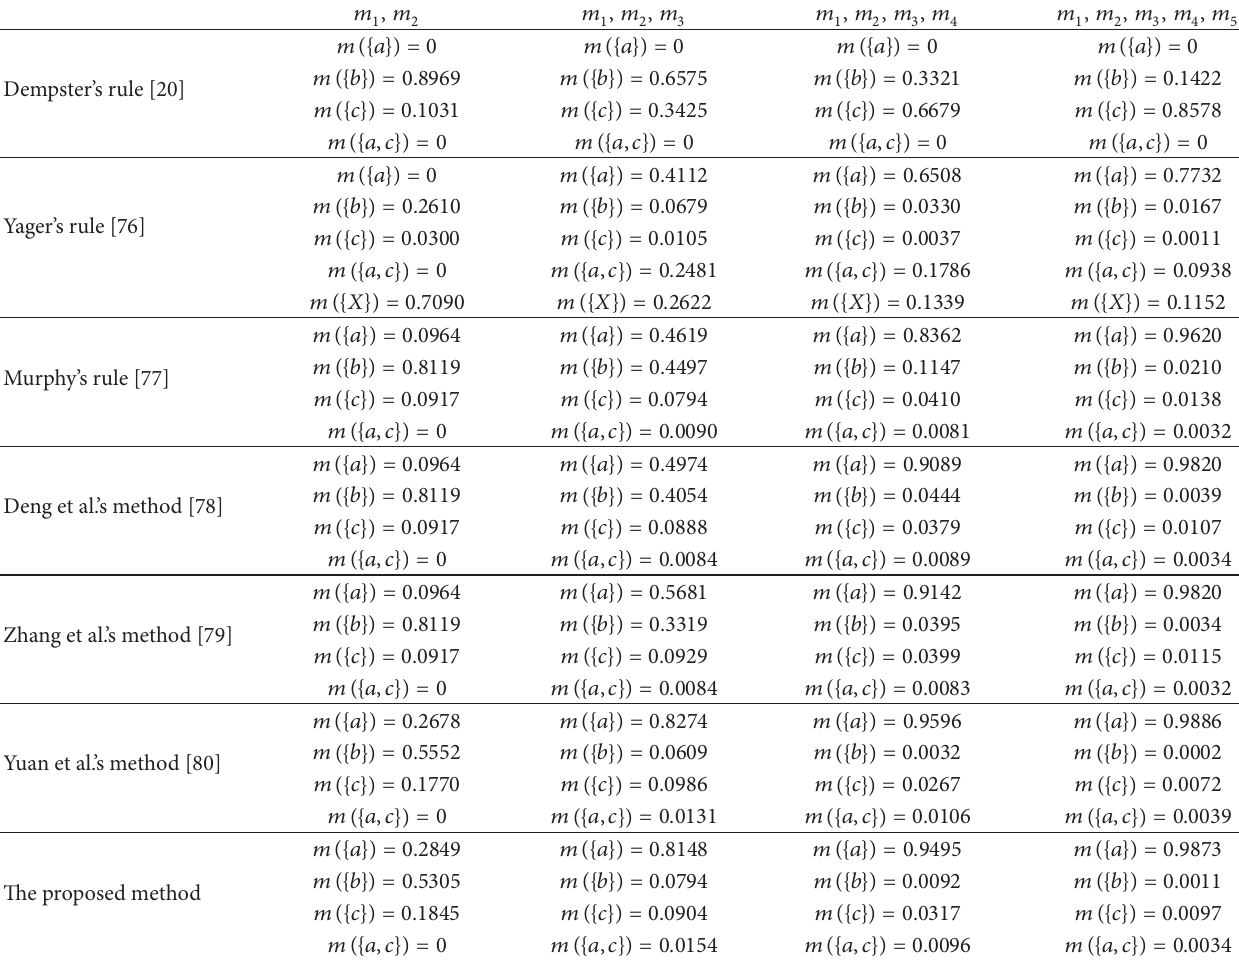
Table 5: Fusion results with different combination